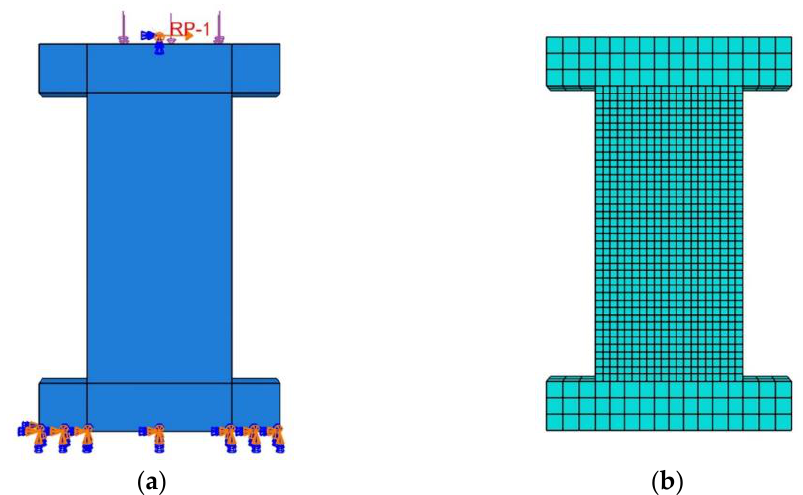
19 of 24 Figure 16. Energy dissipation coefficients of the specimens. 4. Finite Element Analysis 4.1. Finite Element Model Establishment The finite element software ABAQUS was used to conduct a finite element simula- tion comparative analysis of concrete shear walls with a coal gangue replacement rate of 100%. The geometric dimensions and loading system of the coal gangue concrete shear wall finite element model are consistent with the test. The wall, loading, and foundation